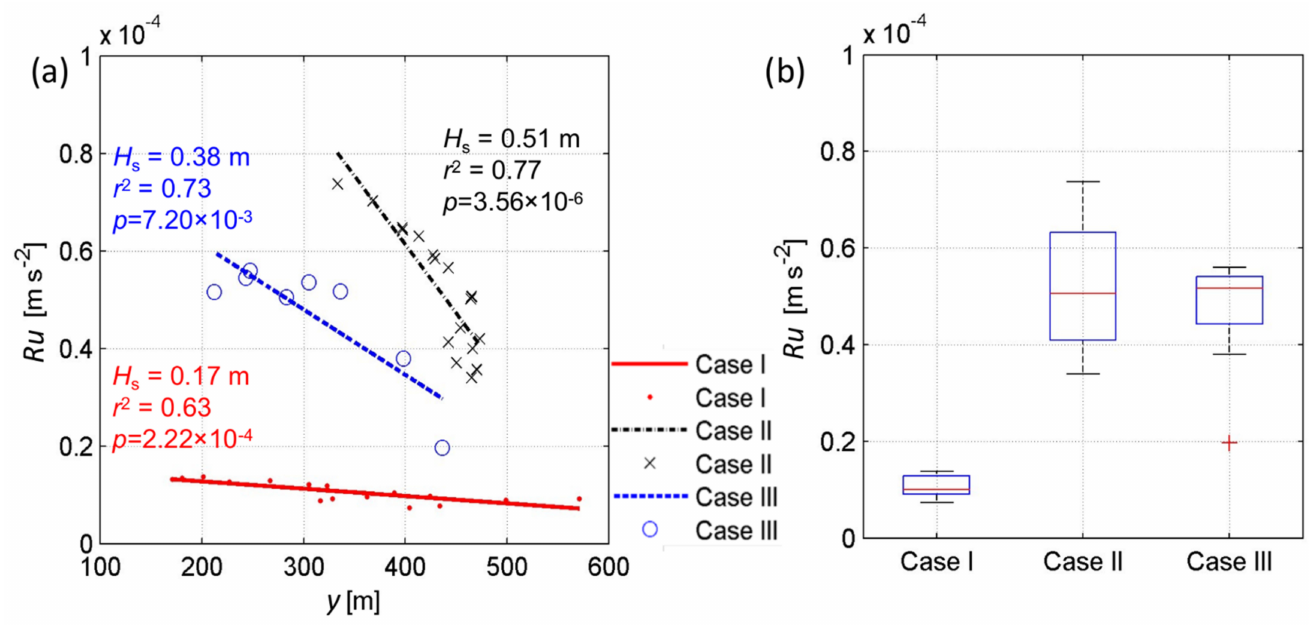
Figure 10. ( a ) Bottom drag term ( Ru in Equation (5)) versus cross-shore location. Symbols and lines indicate the observations and least-squares fit results, respectively, for Case I (red), Case II (black), and Case III (blue). Squared cross-correlation, r 2 , and p-value results for each fit are shown on each panel. ( b ) Boxplots of the bottom drag term for Cases I, II, and III. The horizontal line in the box is the median value, and the bottom and top edges of the box indicate the 25th and 75th percentiles, respectively. The whiskers extend to the most extreme data points (not considering outliers), and the outliers are plotted individually (red